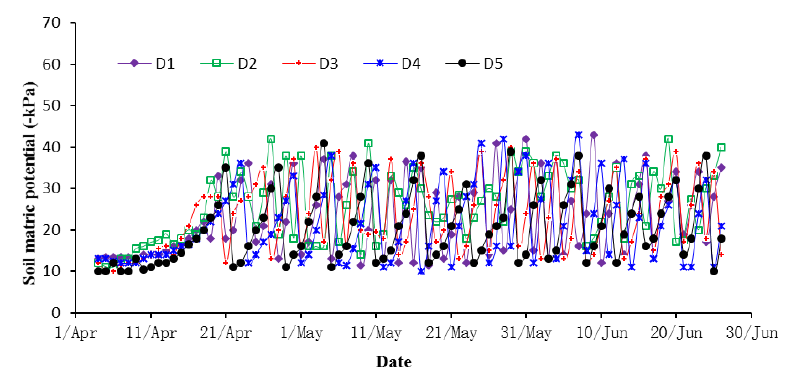
Figure 5. Soil matric potentials at a 20-cm depth for the five treatments.